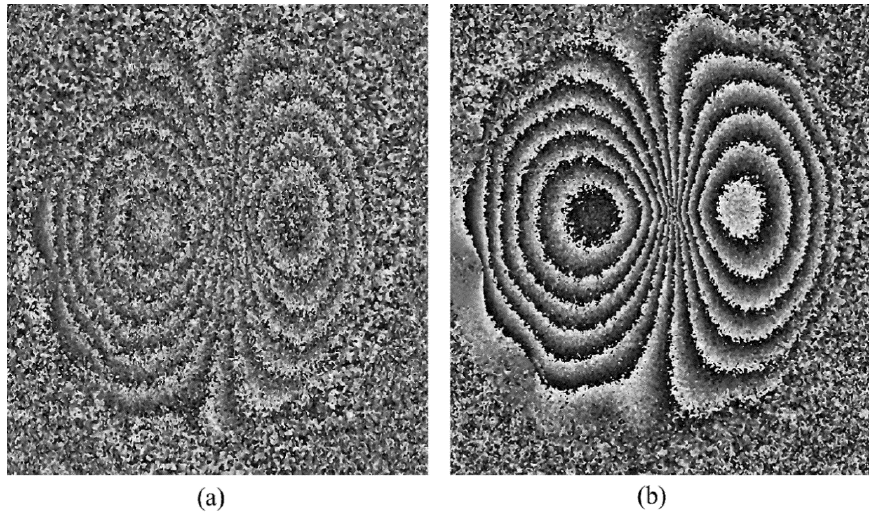
Figure 9. Phase maps generated for a 30 μ m central deformation by the Canon EOS 100D camera for different phase-stepping algorithms, ( a ) 4 + 1 and ( b ) 4 + 4.